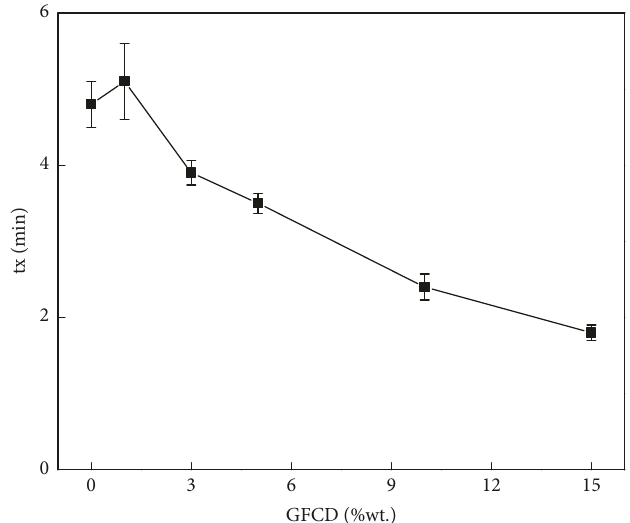
Figure 4: The relationship between the fusion time t